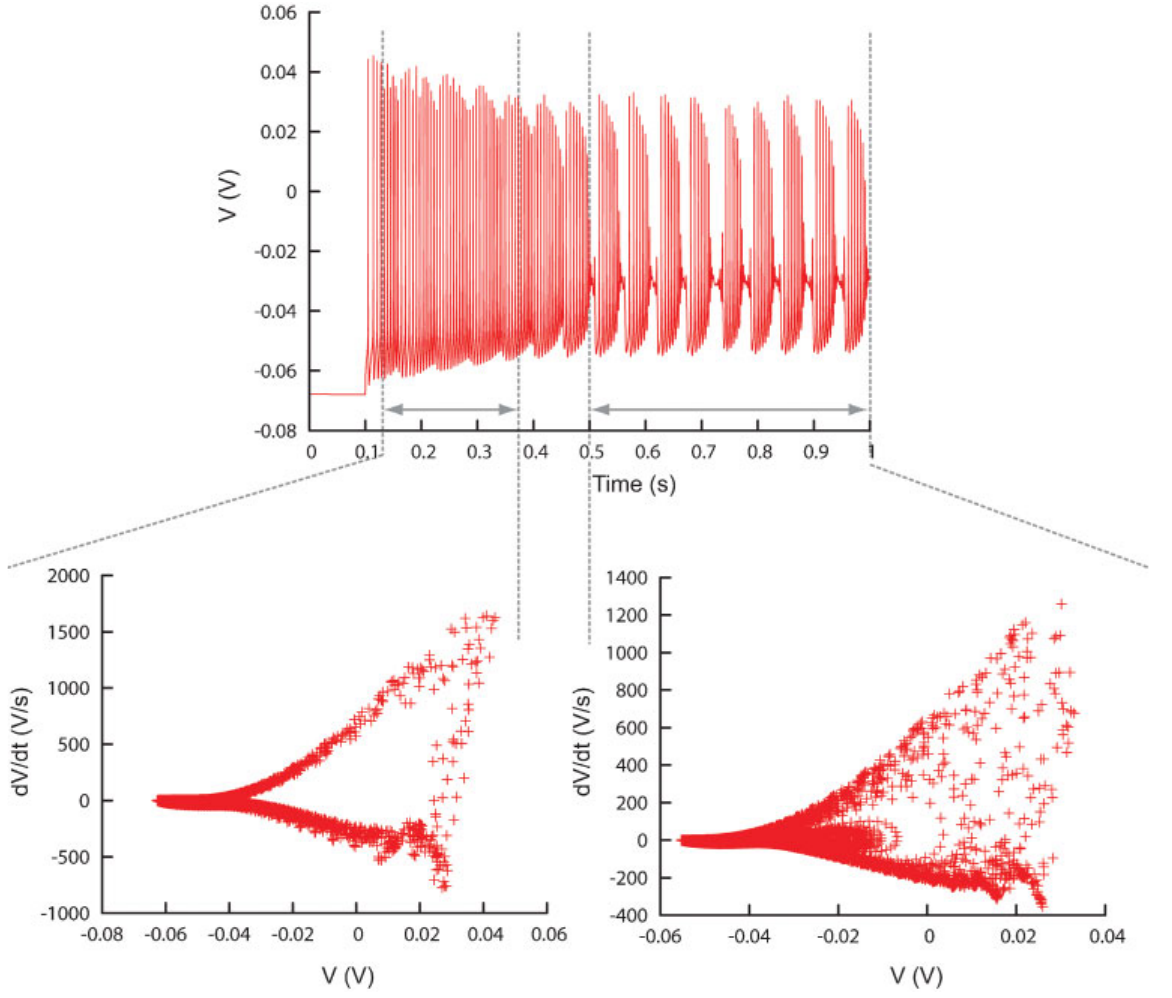
Figure 8. Different time ranges . Plot showing the ability of Neurofitter to calculate the phase-plane trajectory density plot for different time ranges in a trace separately. This enables the user to make a distinction between different firing patterns inside one trace. Example was made using the PC model (De Schutter and Bower,